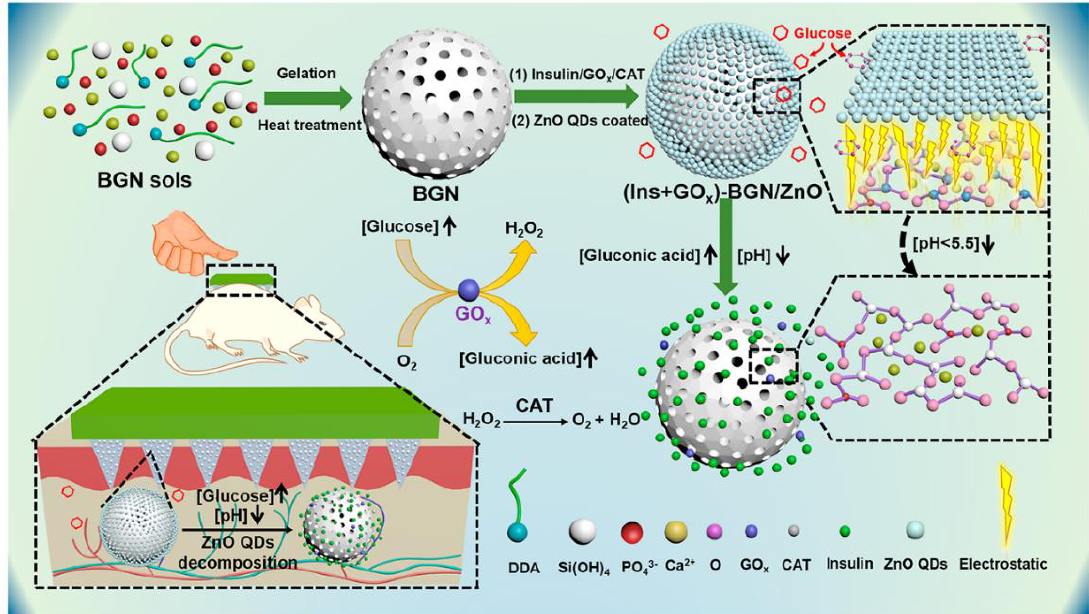
Figure 7. Bioactive glass nanoparticles (BGN) can be manufactured by BGN soles through gelation under high temperatures. These BGNs were filled with GOx / catalase (CAT) inside their pores, and then the NPs were coated by ZnO quantum dots (QDs). As BGLs grow, the pH drops to a value lower than 5.5 as a result of the reaction occurring by GOx. ZnO QDs are dissolved under this low pH, which disintegrates the BGN, and thus, insulin is free to be released from the disassembled particle. The catalase (CAT) enzyme is responsible for reducing the harm caused by H 2 O 2 on the surrounding tissue. Reprinted with permission from [133].